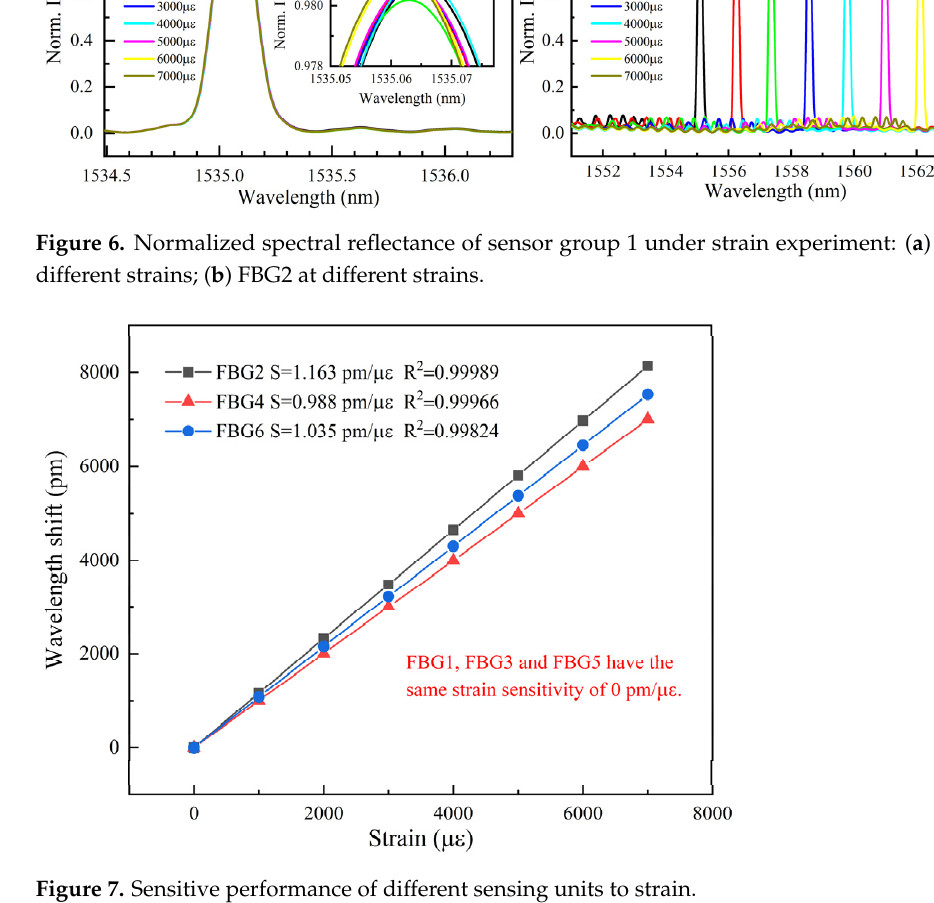
Figure 7. Sensitive performance of different sensing units to strain .